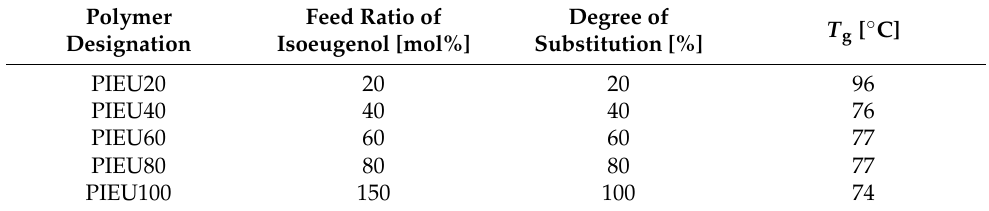
Figure 1. Synthetic route to isoeugenol modified polystyrene (PIEU#), where # indicates the mole percent of isoeugenol containing monomeric units in the polymer. Table 1. Reaction conditions and results for the synthesis of isoeugenol modified polystyrene (PIEU#).